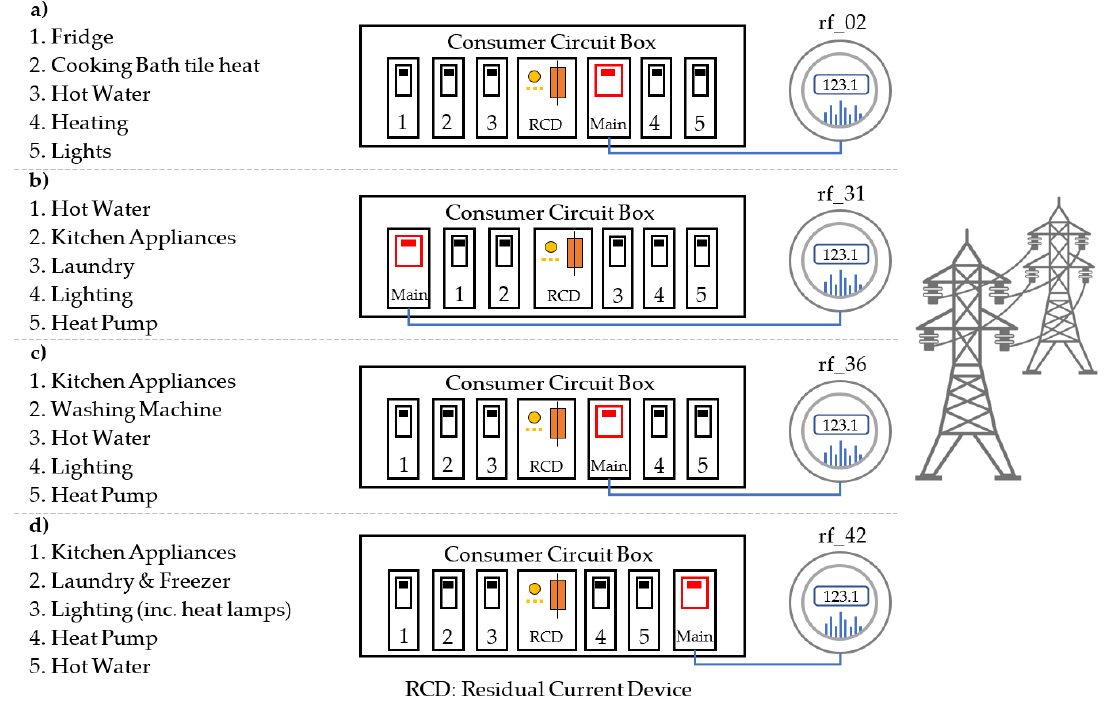
Figure 4. Testing households’ circuits configuration ( a ) rf_02, ( b ) rf_31, ( c ) rf_36, and ( d ) rf_42.